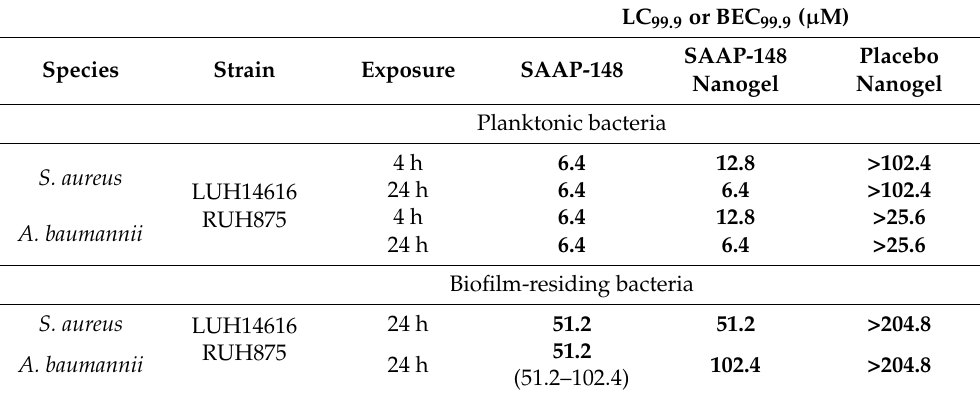
Table 3. Bacterial activities of redispersed PVA-lyophilized SAAP-148-loaded nanogels on planktonic and biofilm-residing AMR S. aureus and A. baumannii compared to SAAP-148 and placebo nanogel. LC 99.9 or BEC 99.9 ( µ